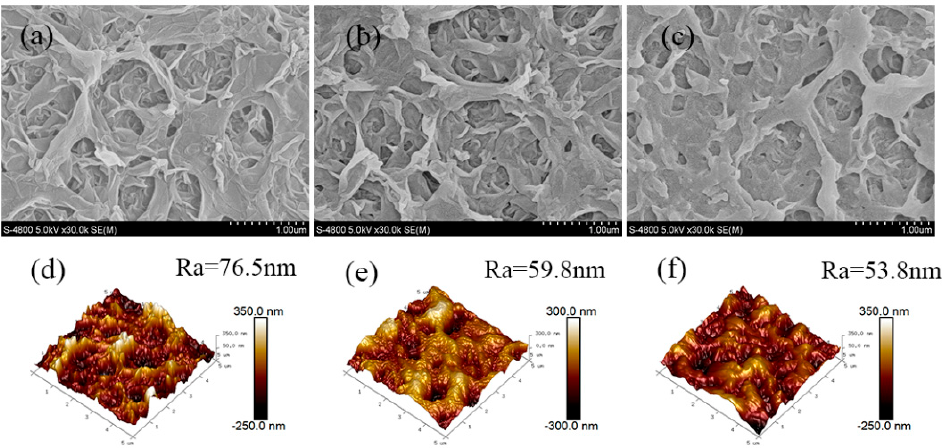
Figure 1. Surface SEM and AFM images of ( a , d ) virgin PA-TFC, ( b , e ) D2/T4, and ( c , f ) D2/T4-PhA membranes.